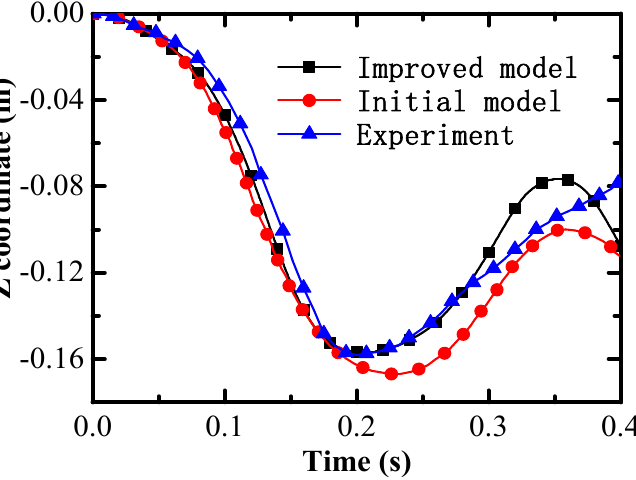
Figure 7. The Z coordinate comparison of point P (experimental data are cited from reference [21]).